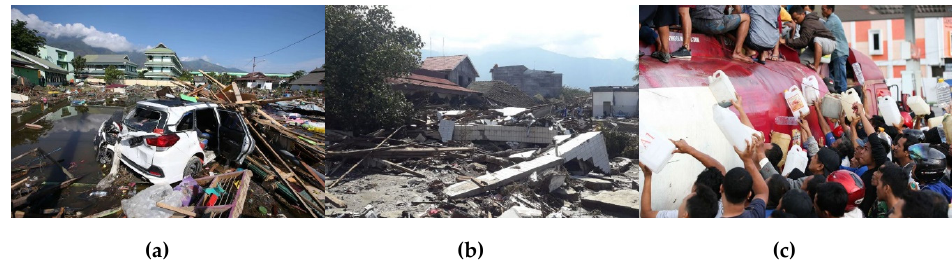
Figure 8. ( a–c ) Images from an earthquake (News